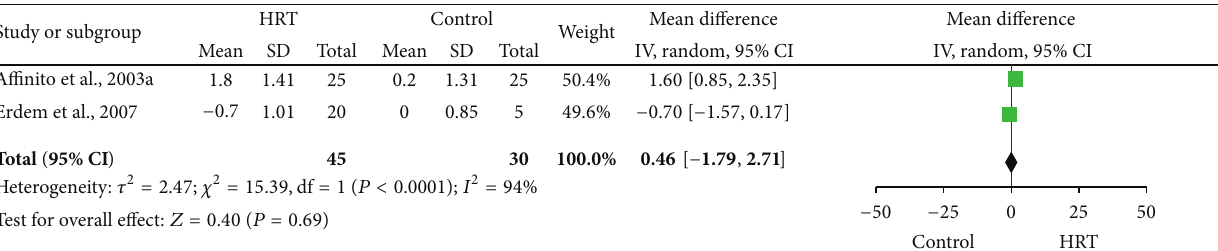
Figure 2: Forest plot of Schirmer score change with anesthetics. Study of Affinito et al. (2003a) indicates that the data were obtained with anesthetics. HRT: hormone replacement therapy; SD: standard deviation; CI: confidence interval; IV: inverse variance.